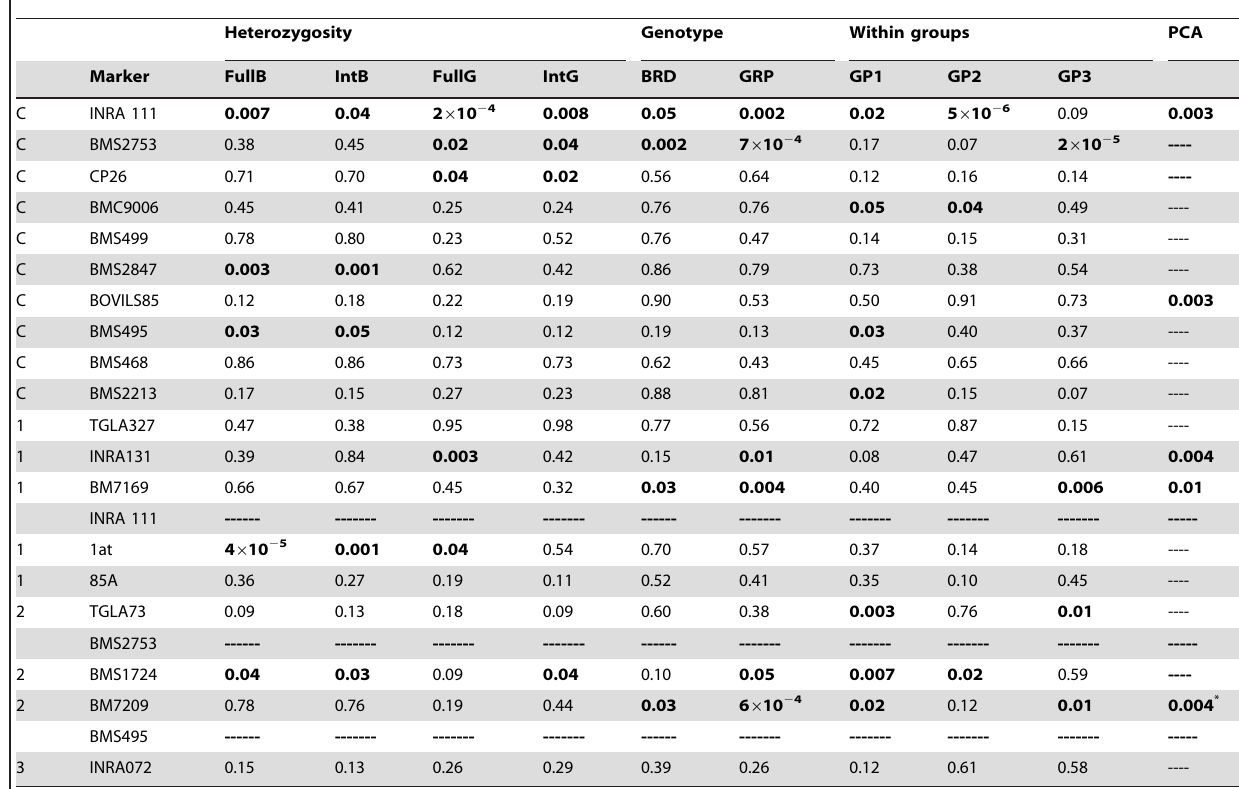
Table 2. Summary of tests of association between bTB and single locus